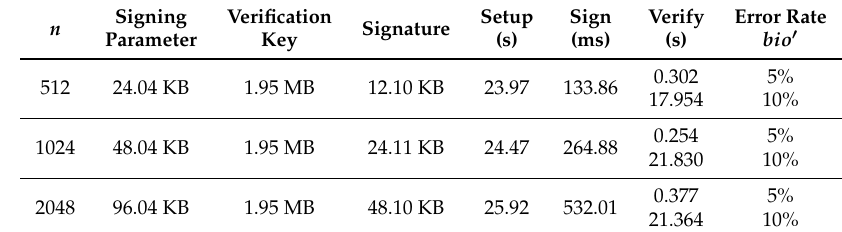
Table 4. Implementation results of FVS using BLS12381 curve in case of error tolerance rate ( t / n ) : 12.5%, the number of components in each subset ( (cid:96) ) : 80, and the number of subsets ( d ) : 15,268 with δ =